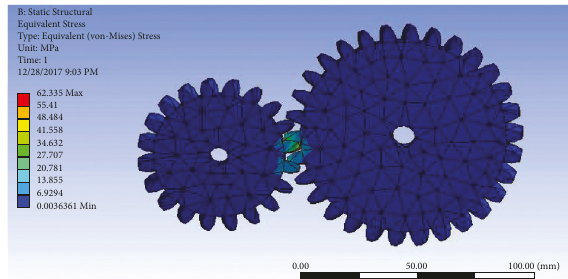
Figure 11: Gear equivalent (von-mises) stress.